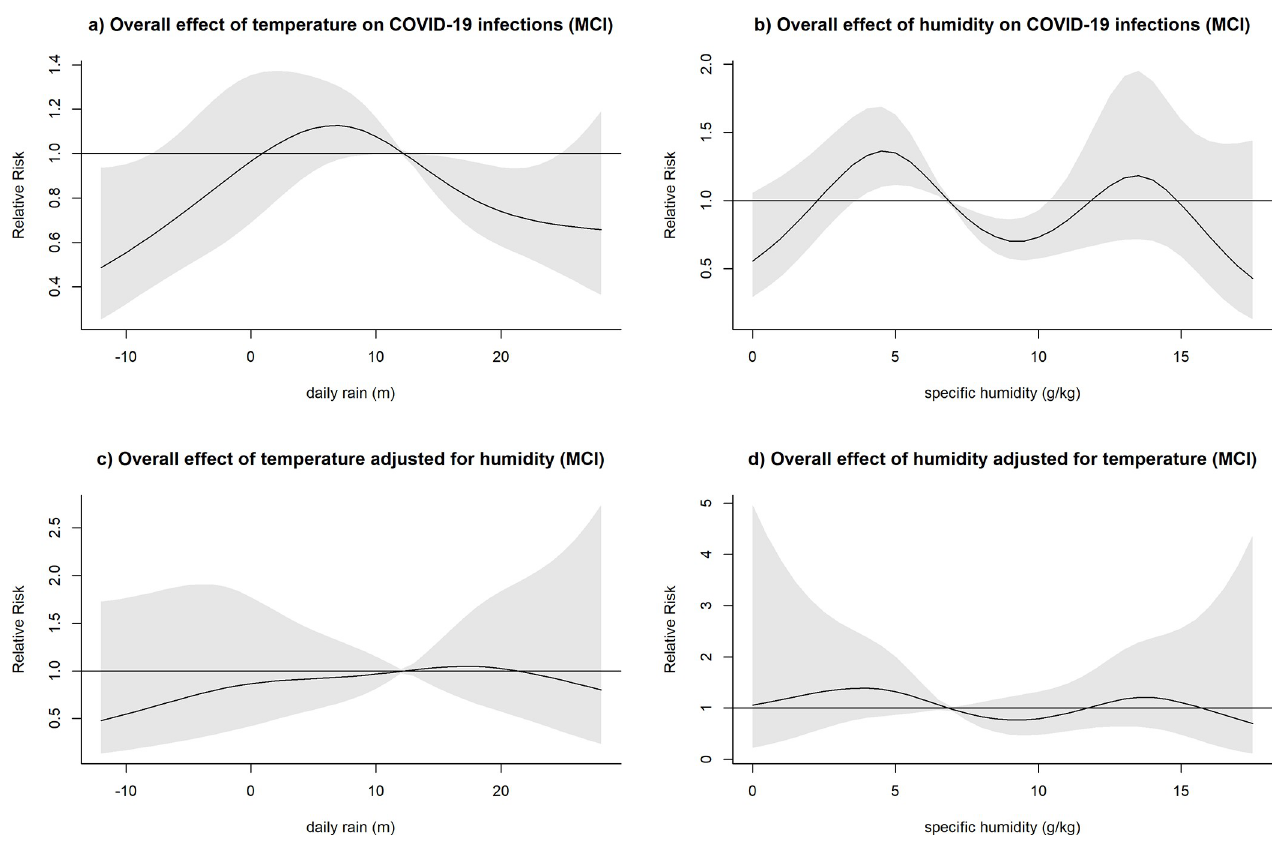
Fig 4. Overall effect of temperature and humidity on COVID-19 infections in Marion County, Indiana (MCI). The relative risk of COVID-19 infection was plotted across the range of temperature/humidity to show the a) Unadjusted effect of temperature; b) Unadjusted effect of humidity; c) Effect of temperature adjusted for humidity; d) Effect of humidity adjusted for